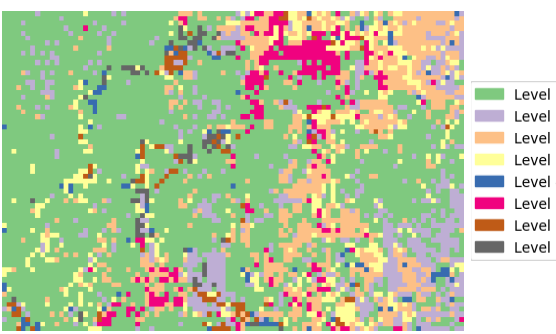
Figure 10. Changes between April 17 th and December 12 th ,